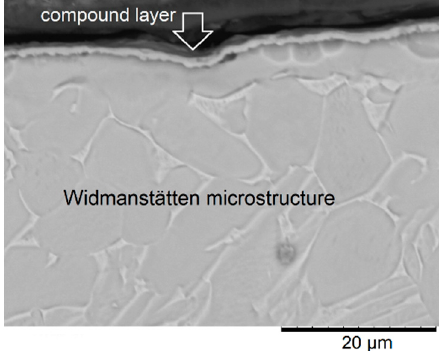
Figure 5. Scanning electron microscopy (SEM) micrograph of plasma-nitrided Ti-6Al-4V with Widmanstätten microstructure.